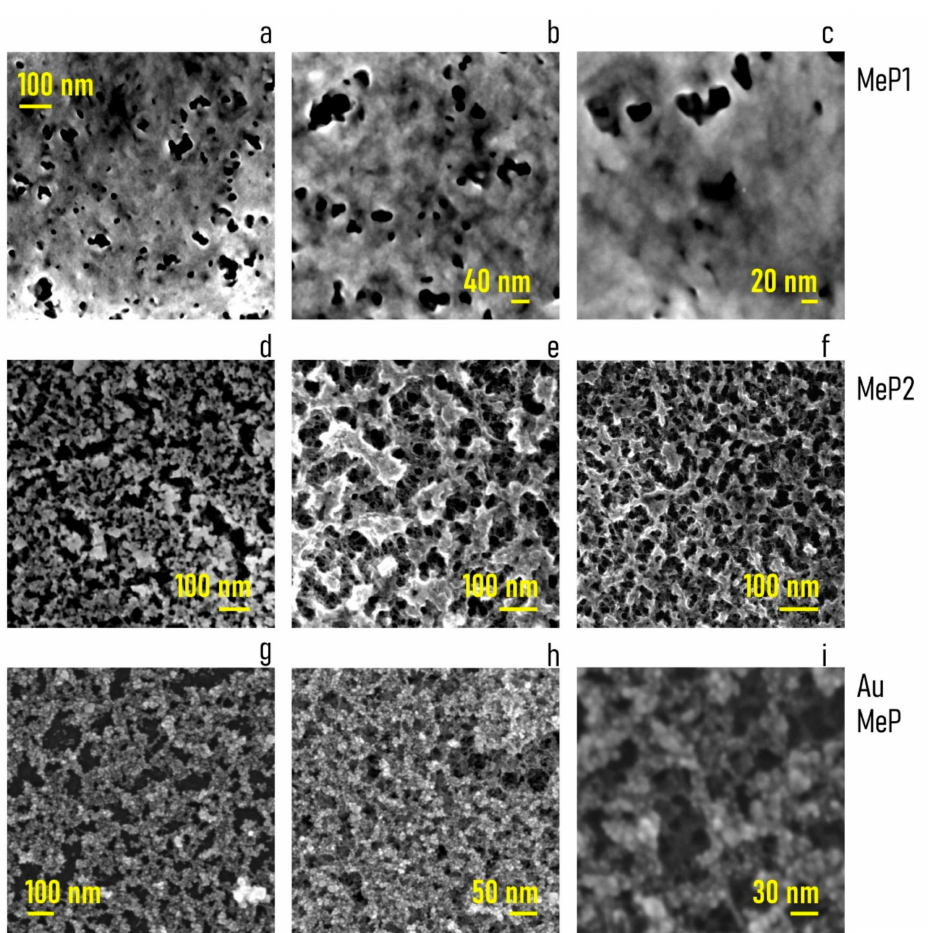
Figure 2. ( a – c ) SEM micrographs of MeP 1 substrates at di ff erent levels of magnification, the pores are less uniformly distributed over the sample surface with an average pore size of PS ≈ 11 nm. ( d – f ) SEM micrographs of MeP 2 substrates at di ff erent levels of magnification, the pores are uniformly distributed over the sample surface with an average pore size of PS ≈ 21 nm. ( g – i ) SEM micrographs of clusters of gold nanoparticles deposited over the porous sample surfaces, the particles follow the profile of the samples without occluding the pores, the average particle size is ≈ 8